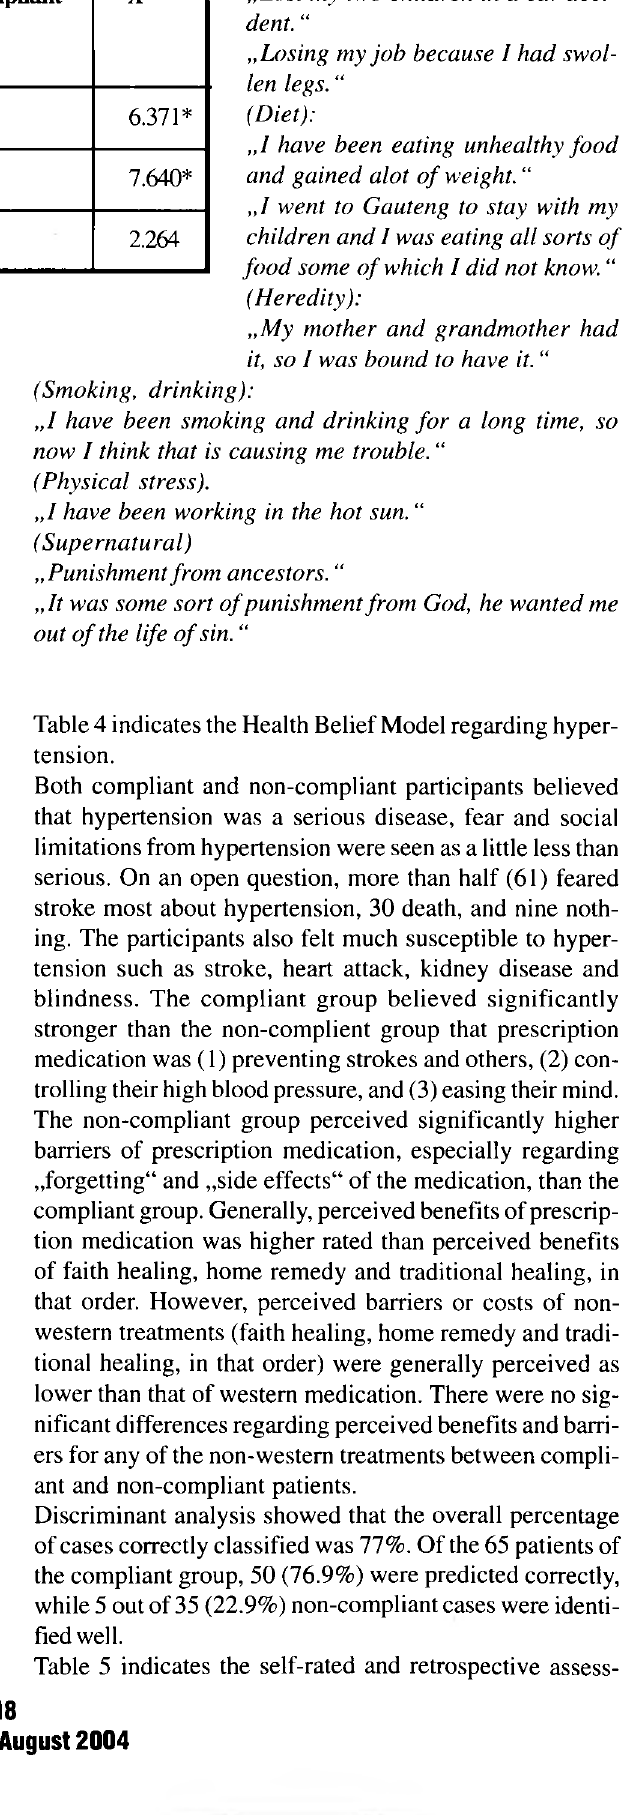
Table 2: Frequency (and in percent) of agreed responses (as opposed to ‘don’t know1 and ‘disagree1) on curability of hypertensives by different healing agents